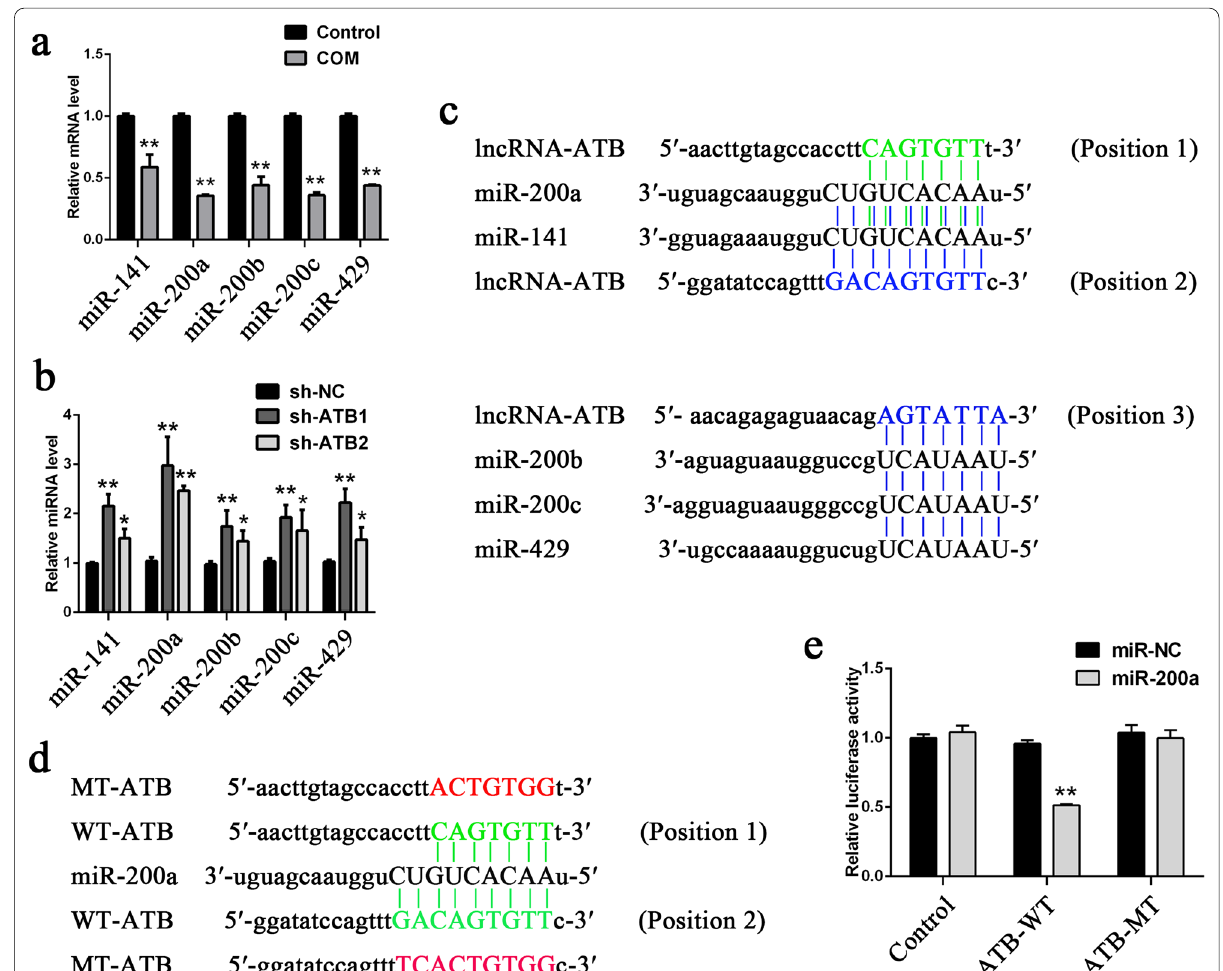
stimulation and b in lncRNA-ATB knockdown cell lines. c The prediction for miR-200 family members’ binding sites on lncRNA-ATB transcript. d The binding sites of miR ‐ 200a on lncRNA-ATB transcript are shown in green, and the mutant sequence is shown in red. e Dual ‐ luciferase reporter assays were performed using HK-2 cells cotransfected with miR-200a and luciferase reporters containing nothing, lncRNA-ATB wild-type (WT) or mutant transcript (MT). All above the experiments were repeated 3 times, values are mean SD; * P < 0.05, ** P < 0.01 VS . Control, sh-NC or miR-NC group ±